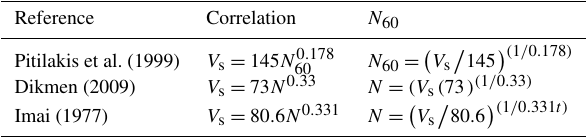
Table 2. Correlations to estimate shear wave velocity.